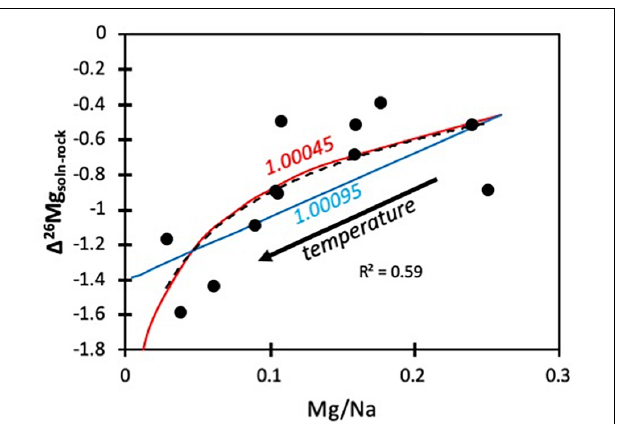
FIGURE 4 | Mg isotope fractionation factors from primary basalt as a function of temperature. FIGURE 5 | Mg isotope fractionation in the hydrothermal springs as a function